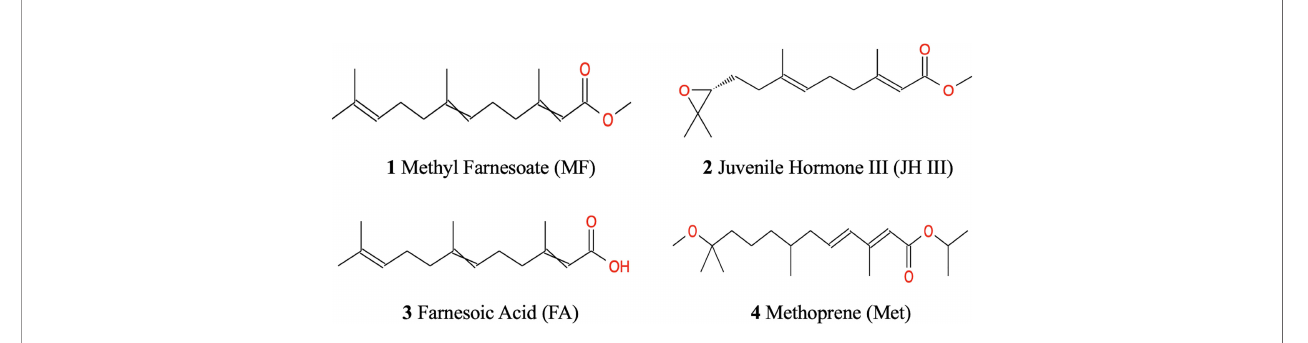
FIGURE 1 | Chemical structures of MF, JH III, FA and